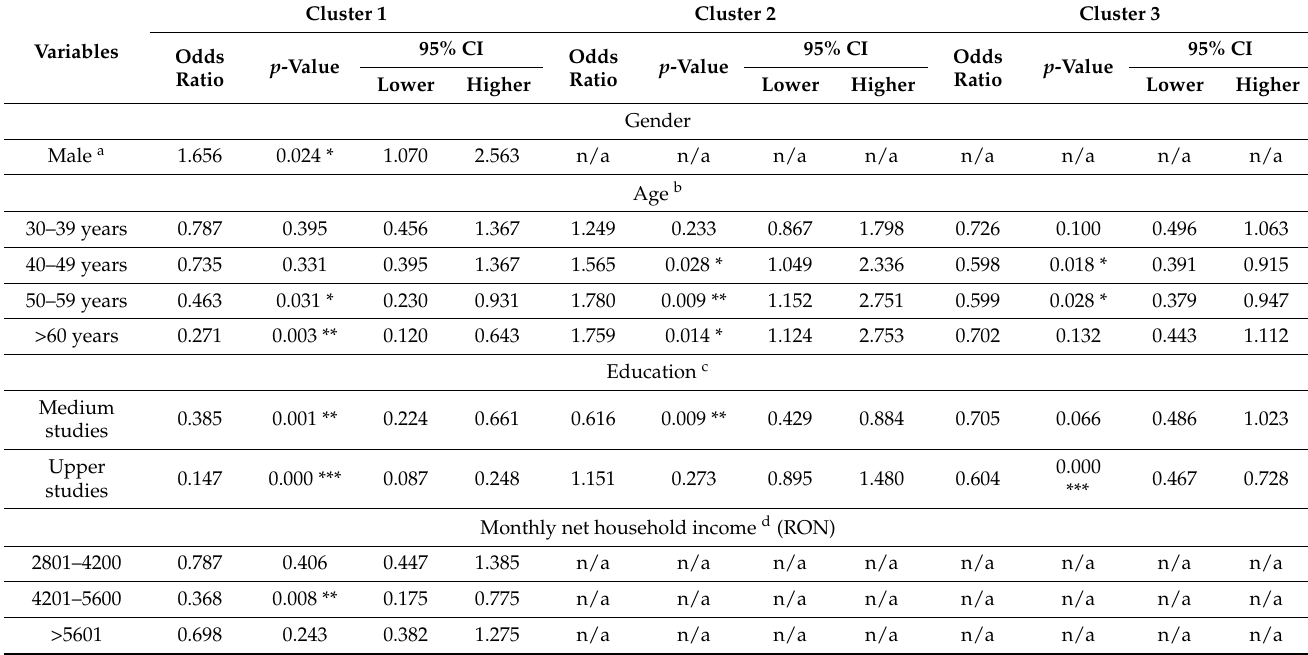
Table 6. Binary logistic regression